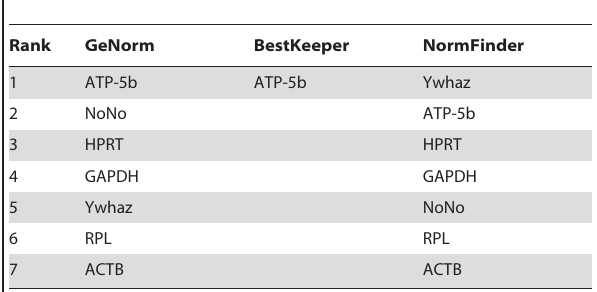
Table 6. Ranking of RGs stability during MCE of 3T3-L1 cells. Table 7. Ranking of RGs stability during TD of 3T3-L1 cells into